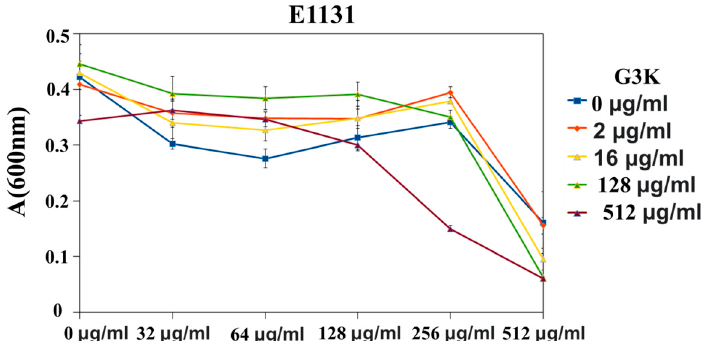
Figure 7. G3K effect evaluation on vanA -resistance-gene-cluster-mediated resistance to TEI in E. faecium . Data represent the mean ± SD, n = 3.